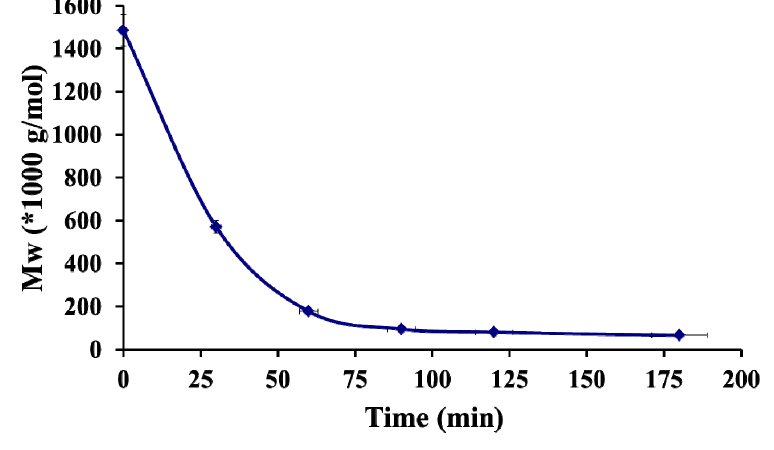
Figure 1. Kinetics of hyaluronic acid depolymerization, [HA] = 1 mg/mL Data are the average of three independent experiments ± standard